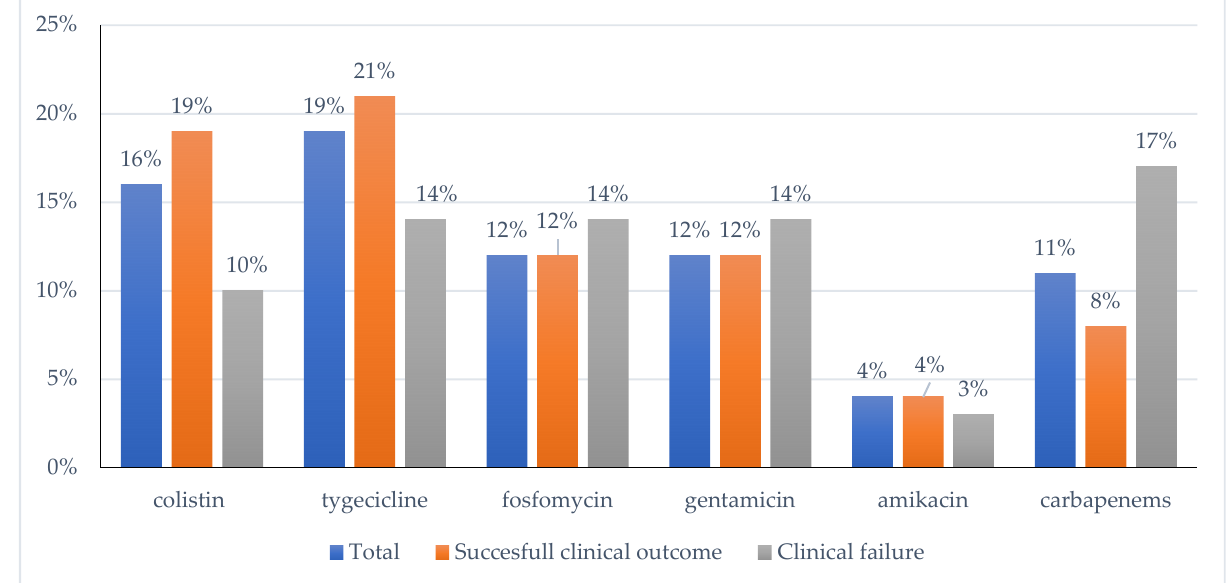
Figure 1. Clinical results of administration of CZA in combination therapy. The percentage showed refers to the total number of patients for each group (total, successful clinical outcome, and clinical failure).